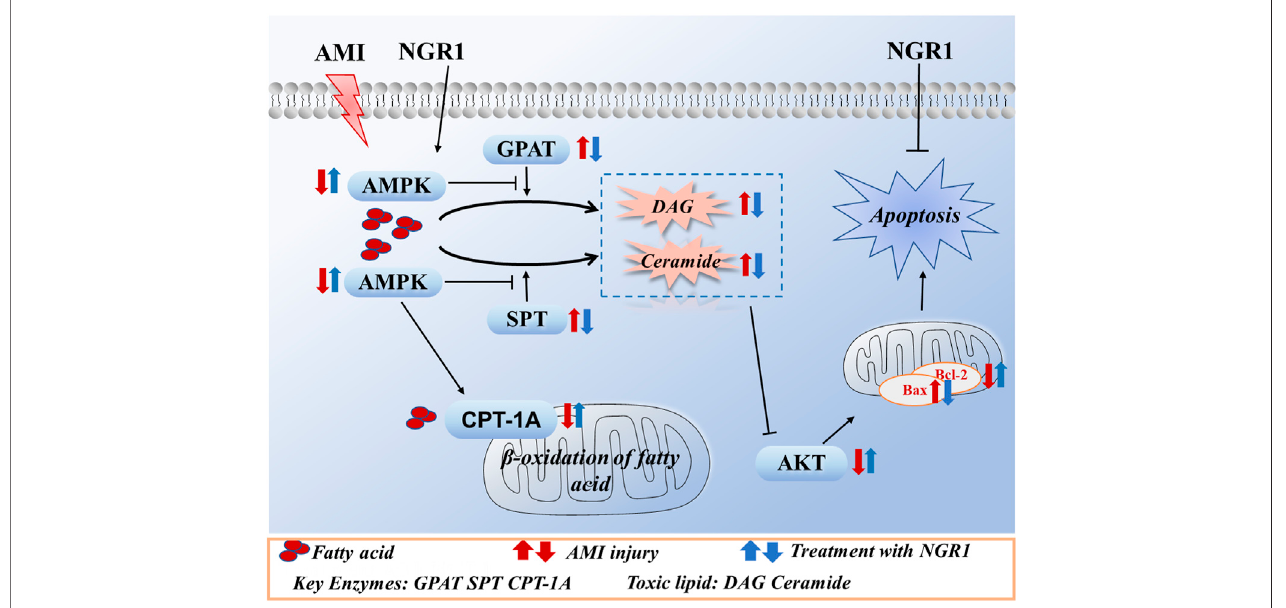
FIGURE 7 | The potential mechanism of NGR1 in attenuating lipotoxicity through AMPK signal pathway.